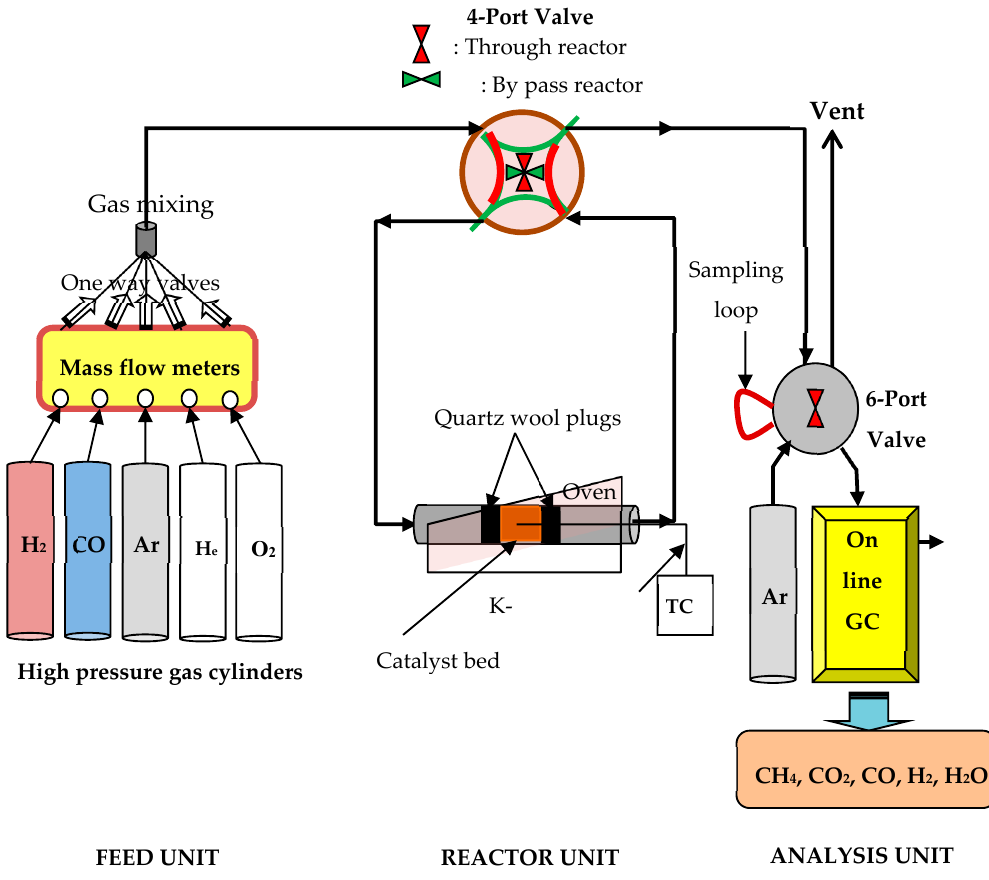
Figure 10. Schematic diagram of the continuous flow experimental apparatus used for catalyst performance evaluation.